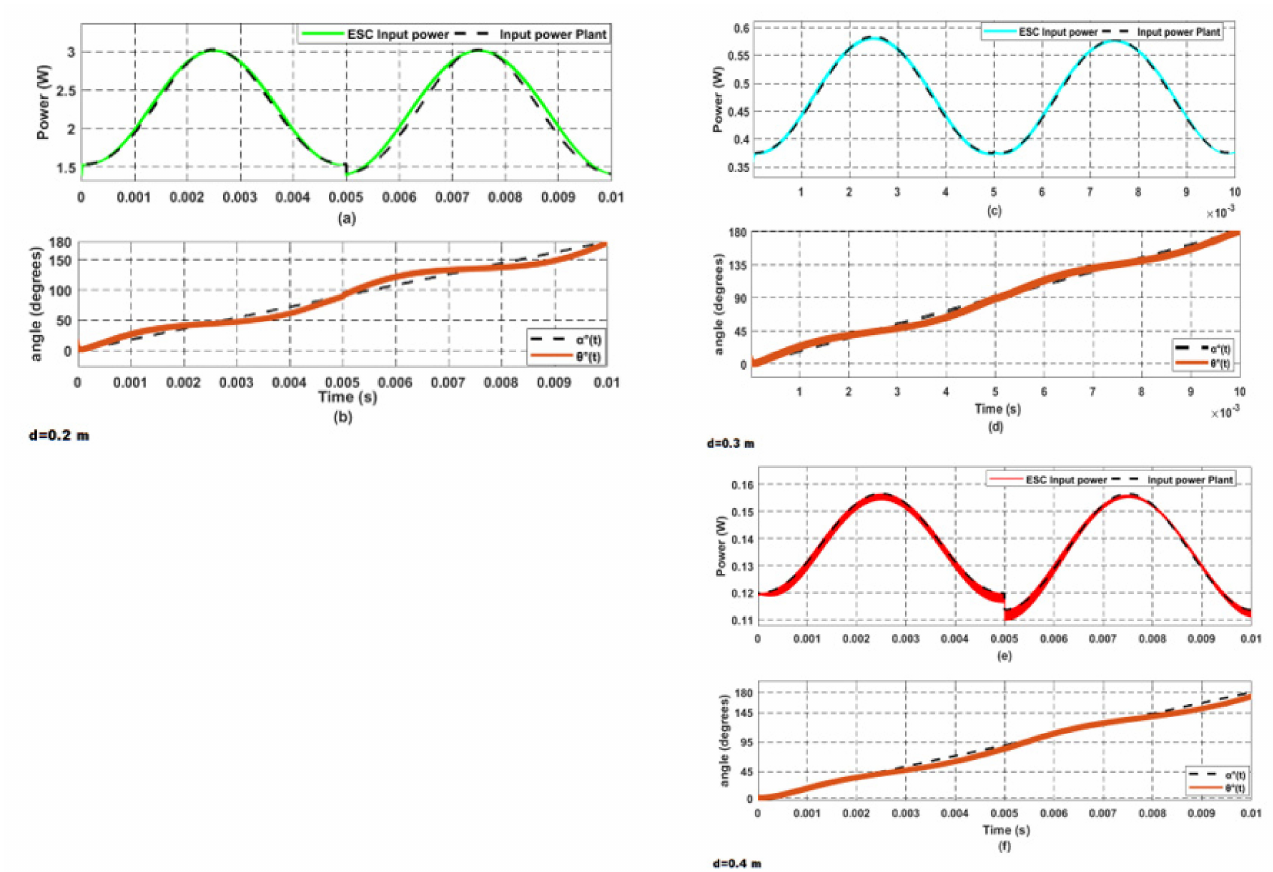
Figure 17. ( a , c , e ) ESC maximization of the input power for different values of distance of ( b , d , f ). ESC of the magnetic resultant angle θ optimization for different values of d